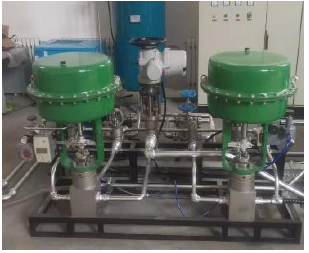
Figure 9. Electric automatic control valve.